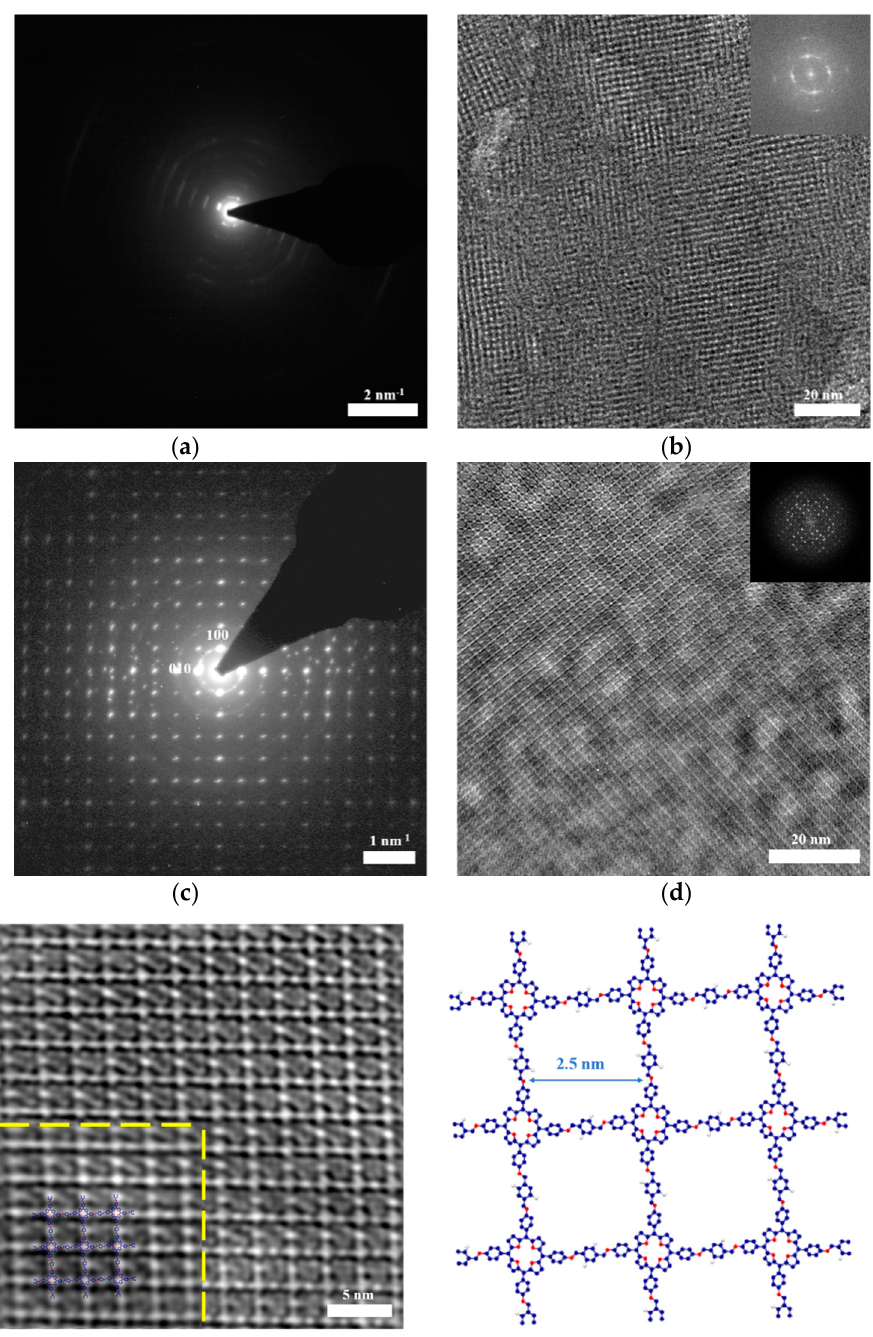
Figure 7. ( a , b ) SAED and TEM of COF-366 film without CNCs; ( c , d ) SAED and TEM of COF-366 film with 100 μ L CNCs; ( e ) HR-TEM image of COF-366 film with 100 μ L CNCs (Inset: simulated HR-TEM image with the atomic model overlaid); ( f ) structure simulation of COF-366 by Materials Studio software (carbon: blue, nitrogen: red, oxygen: white).